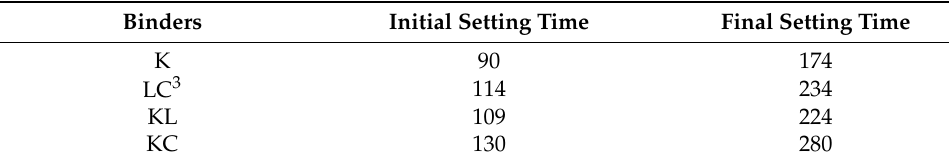
Table 4. Initial and final setting times (in min) of blended